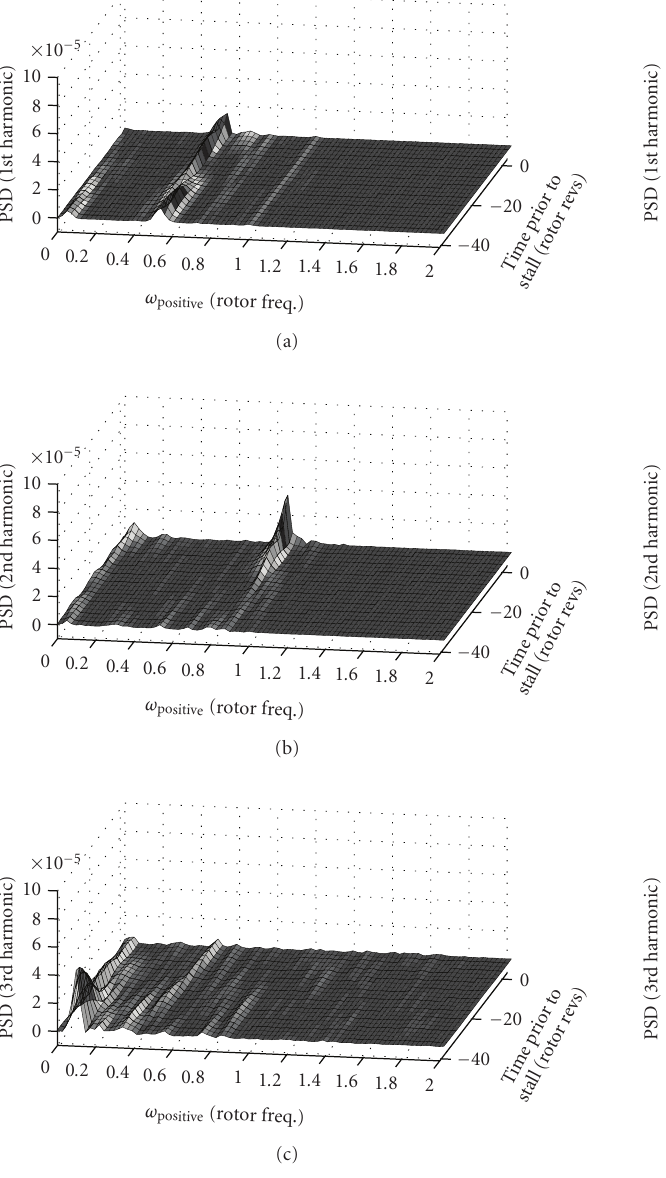
Figure 19: PSD of first three spatial harmonics of measured pre- stall disturbance with first and second harmonic control (positive rotating